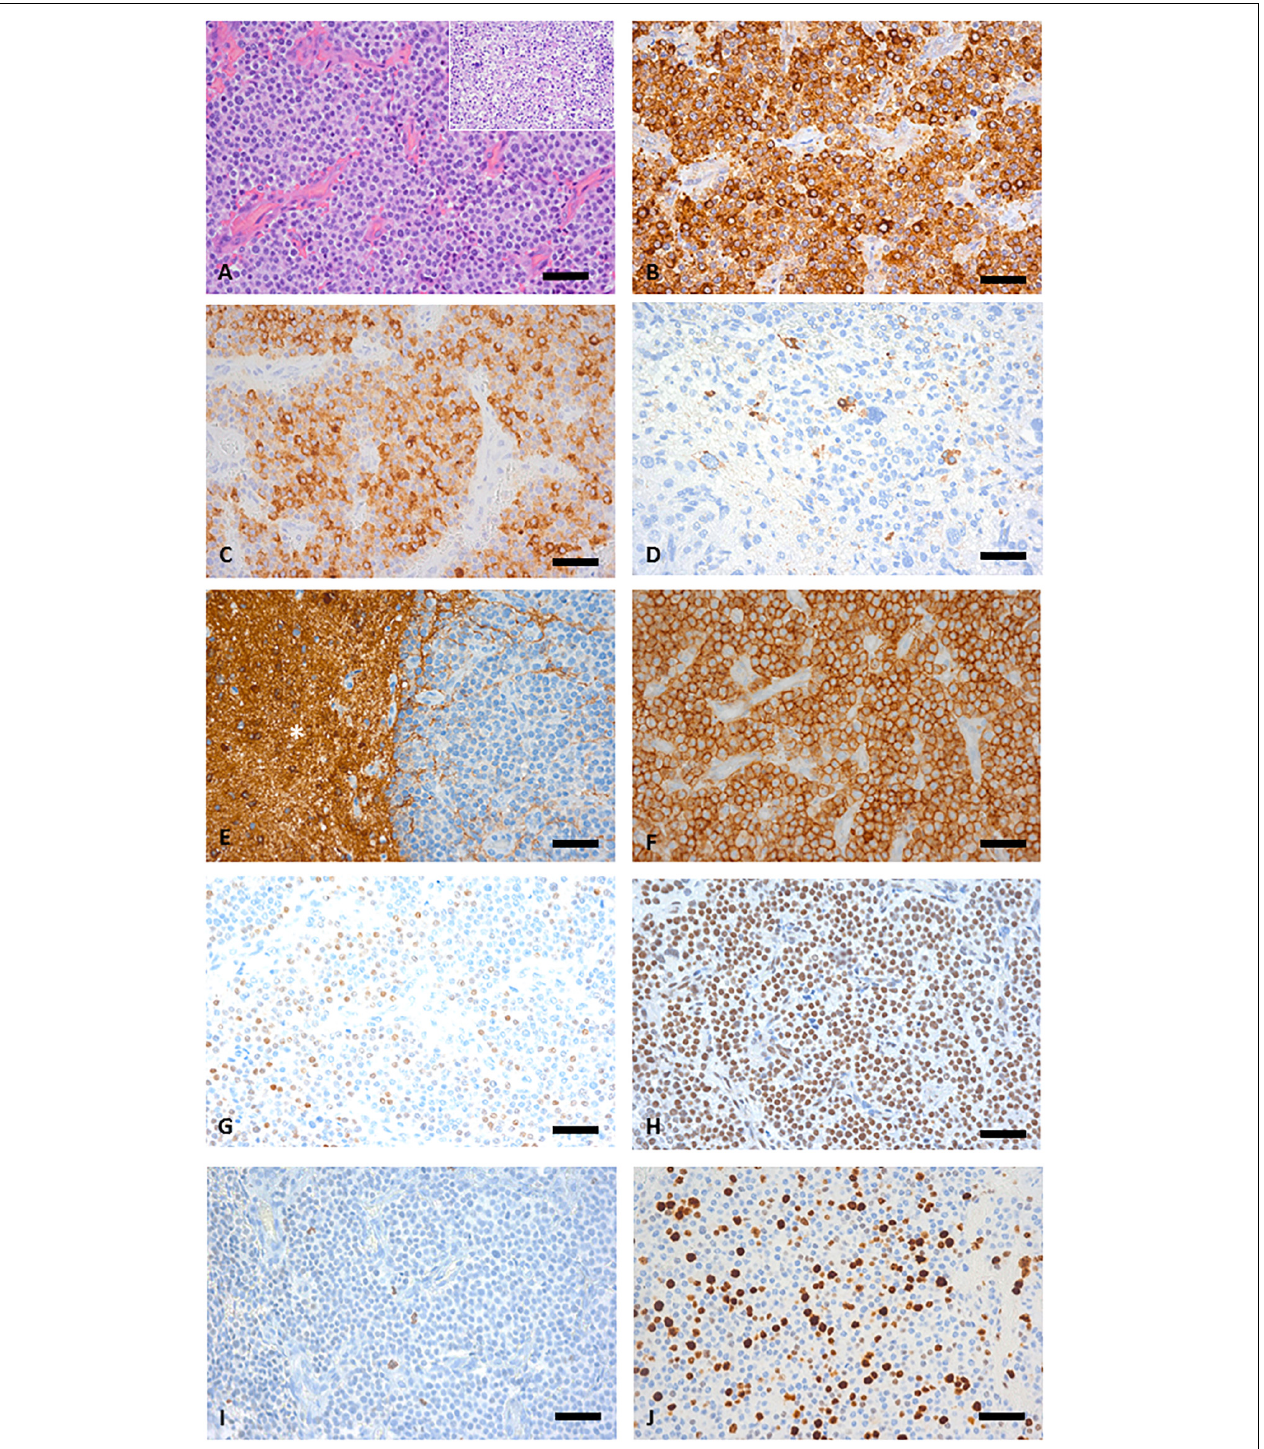
FIGURE 2 | (A) Hematoxylin and eosin (HE) sections of the biopsy specimen showing a highly cellular tumor growing in a sheet-like pattern separated by fibrovascular septa, inset depicts an area with pleomorphic tumor cells. (B) Staining with pan-cytokeratin [Lu-5] antibody confirms an epithelial origin. (C) Anti-Chromogranin A staining is positive in most tumors cells. (D) Only few scattered synaptophysin positive tumor cells were detectable. (E) NCAM staining was negative in the tumor tissue but the asterisk (*) indicates positive NCAM staining in the adjacent white matter. (F) Widespread SSTR2 expression. (G) NeuN showing a moderate intensity in a fraction of tumor cell nuclei. (H) Widespread expression of OTX2. (I) pHH3 reveals frequent mitotic figures. (J) Ki67 proliferation; 35.4%. (A–J) Original magnification x400, scale bar represents 50 µ m.